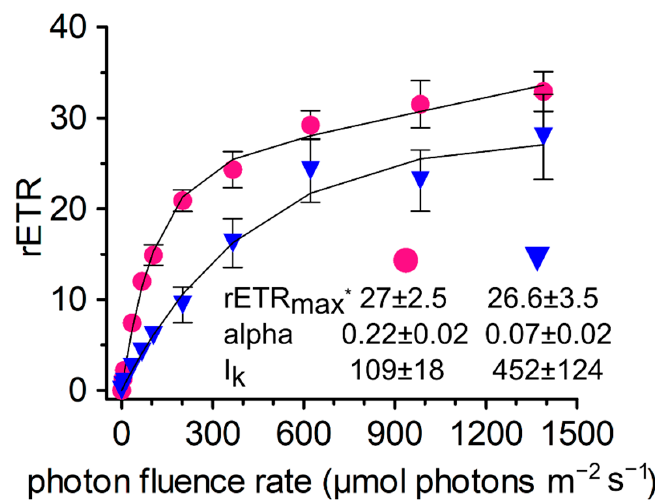
Figure 4. Photosynthetic rapid light curves of Ancylonema alaskana (pink circles) and Ancylonema nordenskioeldii (blue triangles). The effect of increasing photon fluence rates ( x -axis) on the relative electron transport rate (rETR; y -axis) in chloroplasts was measured with field samples (WP167 and WP211) (n = 4, ±SD). The maximal rETR value achieved at 1500 µmol photons m − 2 s − 1 (*). The data points were fitted to the model, assuming no photoinhibition [39].